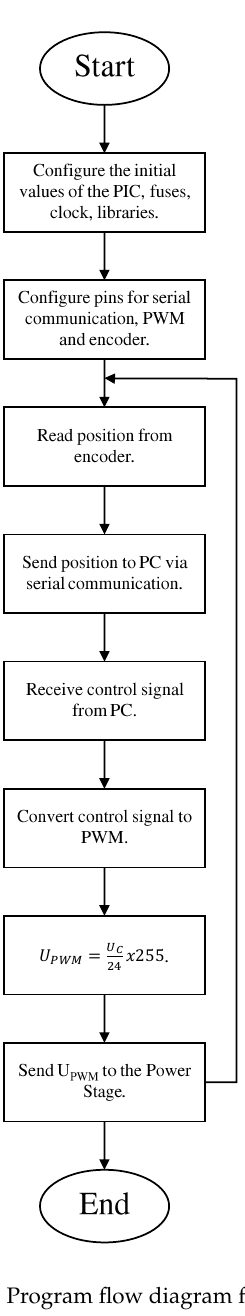
Figure 3. Program flow diagram for the